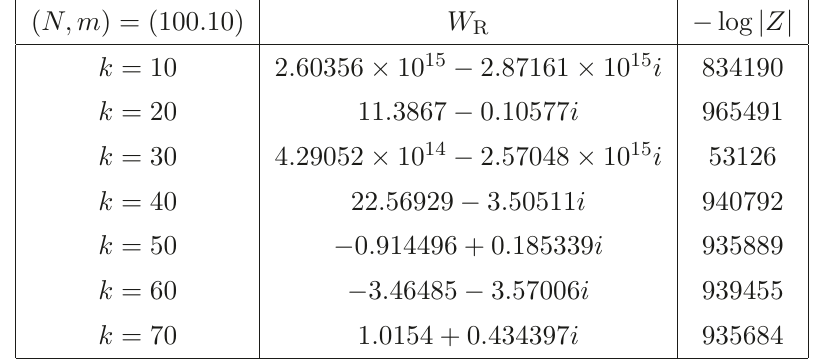
Table 3 . The value of Wilson loop and free energy corresponding to the split solution discussed in the previous subsection from numerical